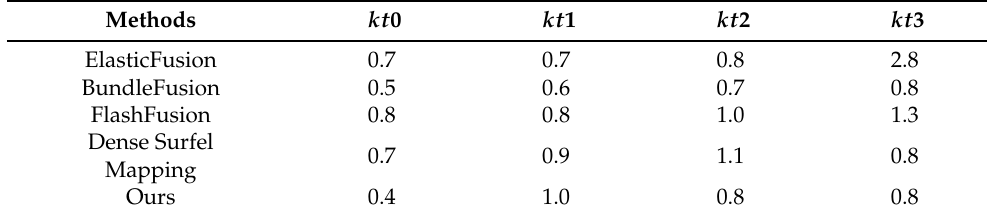
Table 1. Reconstruction accuracy on ICL-NUIM (cm).